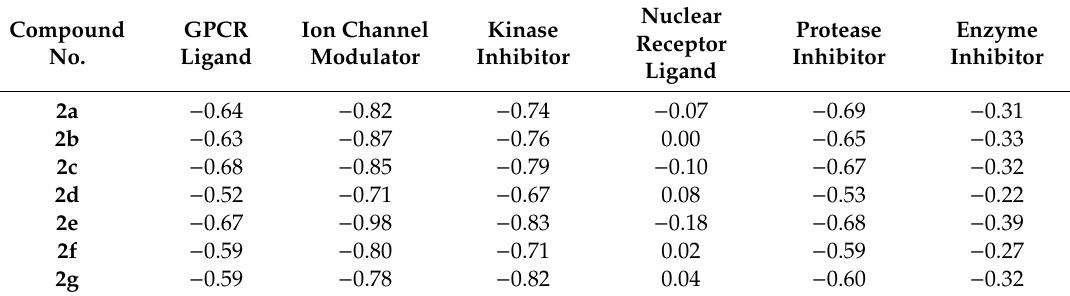
Table 1. The bioactivity of the selected compounds 2a – 2g .